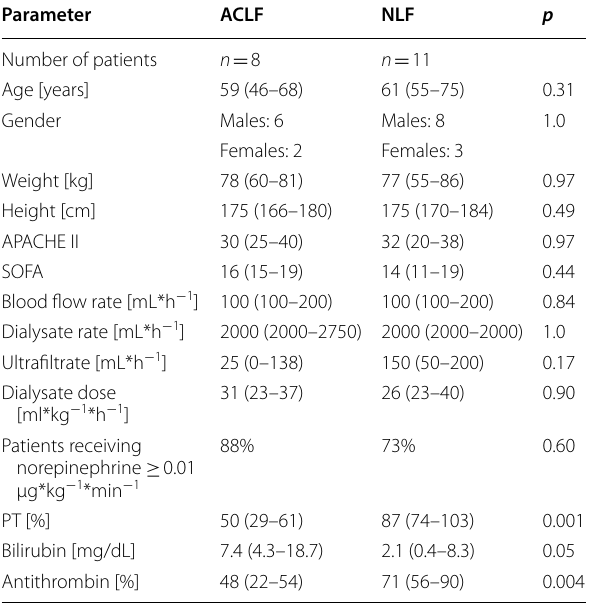
Table 1 Patients’ characteristics Table 2 Parameter estimates for meropenem from the